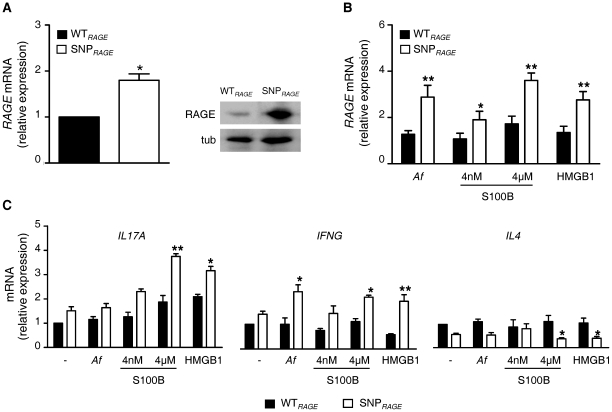
Functional consequences of RAGE -374T/A polymorphism.Analysis of RAGE expression in PBMCs from wild-type (WTRAGE, TT genotype) or mutant homozygous (SNPRAGE, AA genotype) individuals (A) untreated or (B) stimulated with A. fumigatus conidia (Af), S100B and HMGB1. In (A), a representative Western blot of RAGE in untreated WTRAGE and SNPRAGE PBMCs is shown. Tub, tubulin. (C) Cytokine gene expression in human PBMCs isolated from WTRAGE or SNPRAGE individuals. Data are shown as mRNA relative expression using untreated WTRAGE cells as reference (for every assay, shown is the mean±SD of data obtained for 10 individuals of each genotype; *P≤0.05 and **P≤0.01 by unpaired t-test). Cells from the same individuals were used across conditions in each assay.